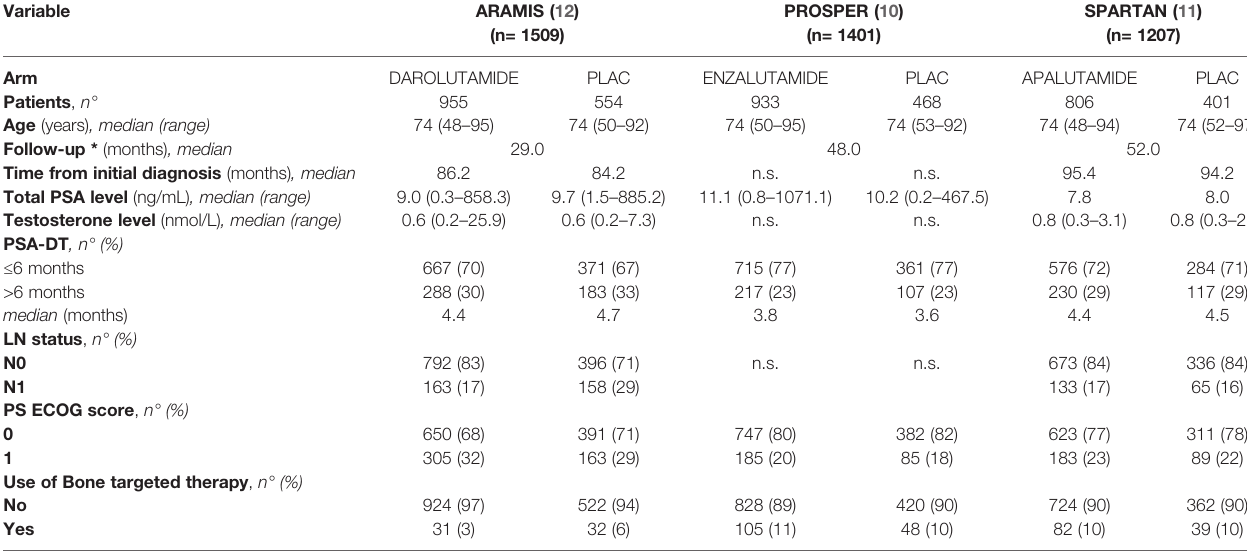
TABLE 1 | Patients baseline characteristics in the 3 included studies by treatment group [number of cases (%), and median